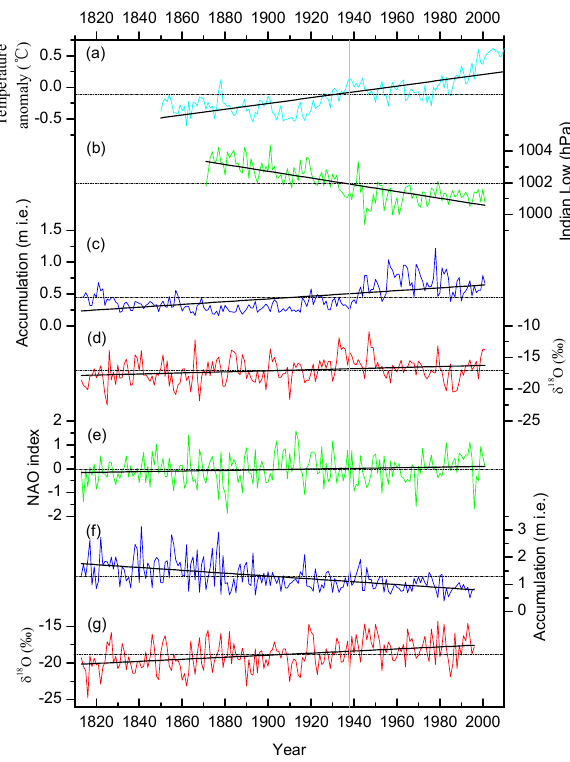
Fig. 2. Variations of (a) Northern Hemisphere annual temperature anomaly (Jones et al., 2013), (b) the Indian Low intensity, (c) the ER annual accumulation rate, (d) the annual mean ER δ 18 O, (e) the non-monsoon-season (October to May) NAO index (Luterbacher et al., 2002), (f) the DSP annual accumulation rate, and (g) the annual mean DSP δ 18 O since 1813. The short dash-dotted lines are the averages of each series, and the bold lines are their linear trends. The vertical grey line indicates the boundary year